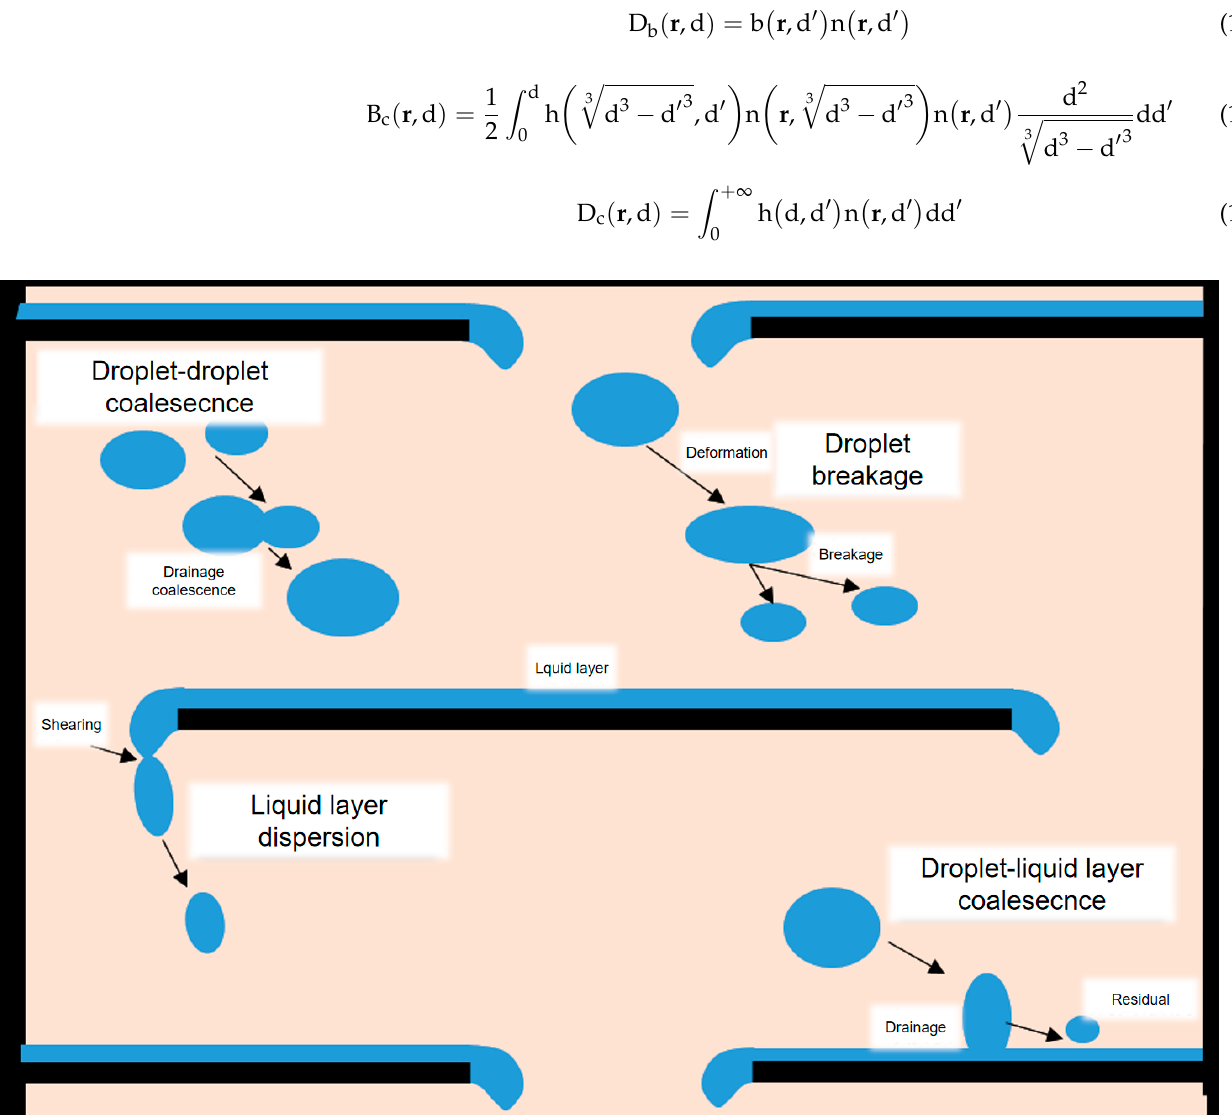
Figure 1. Droplet behaviors in a pulsed disc-and-doughnut column with wettable internal plates [44].